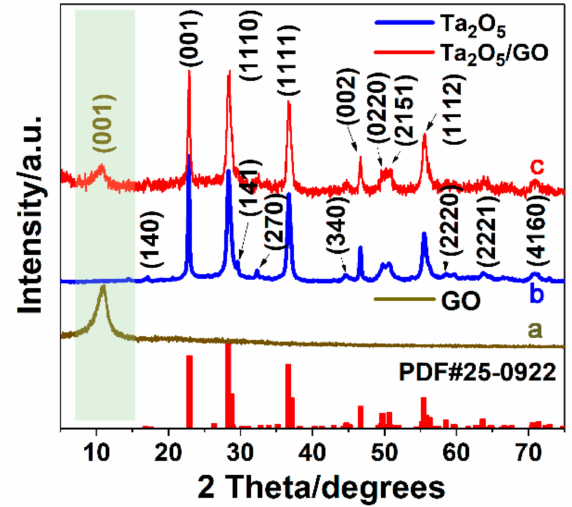
Figure 1. X-ray di ff raction (XRD) patterns of graphene oxide (GO) nanosheets ( a ), pure Ta 2 O 5 nanoparticles ( b ) and Ta 2 O 5 -GO composites ( c